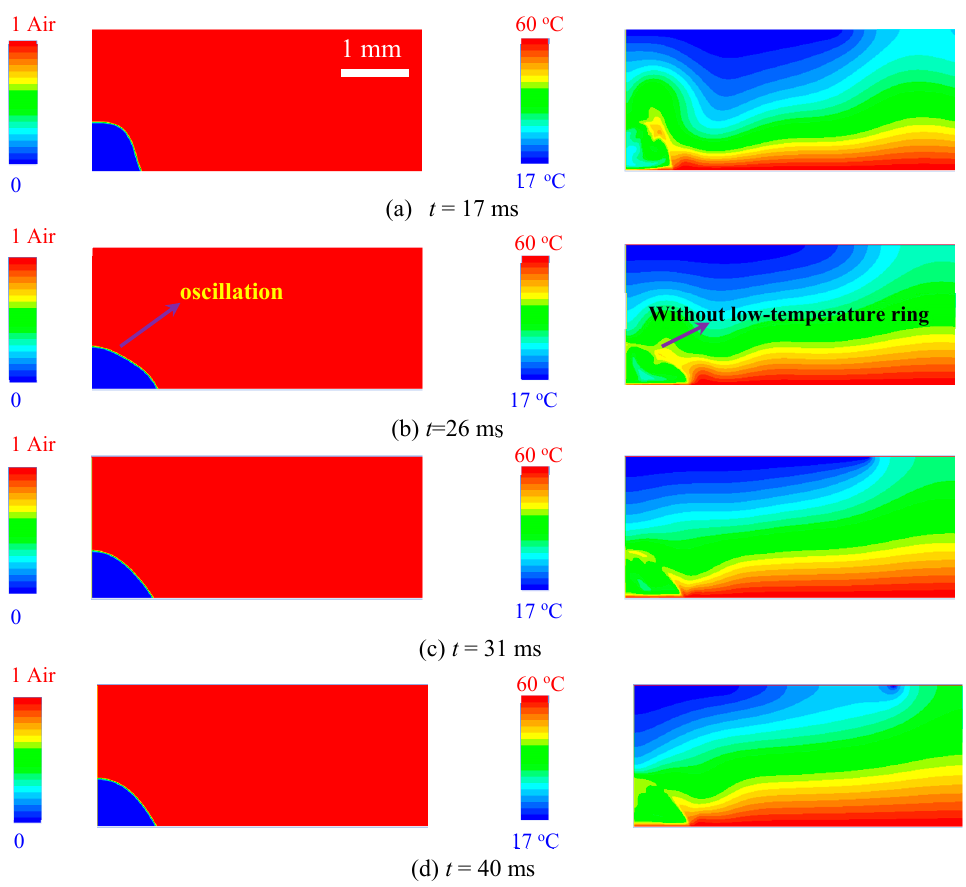
Figure 11. Figure 11. Phase and temperature distribution of the liquid film on hydrophilic surface for W e = 16, T w = 60 ◦ C ( a ) t = 17 ms, ( b ) t = 26 ms, ( c ) t = 31 ms, ( d ) t = 40 ms. The bottom left corner is the droplet impact